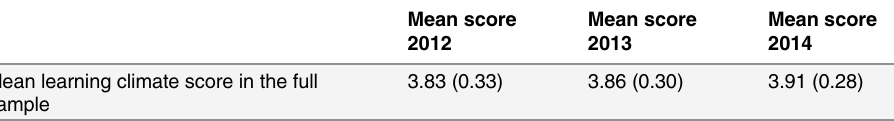
Table 2. Mean learning (D-RECT) scores in 2012, 2013 and 2014.